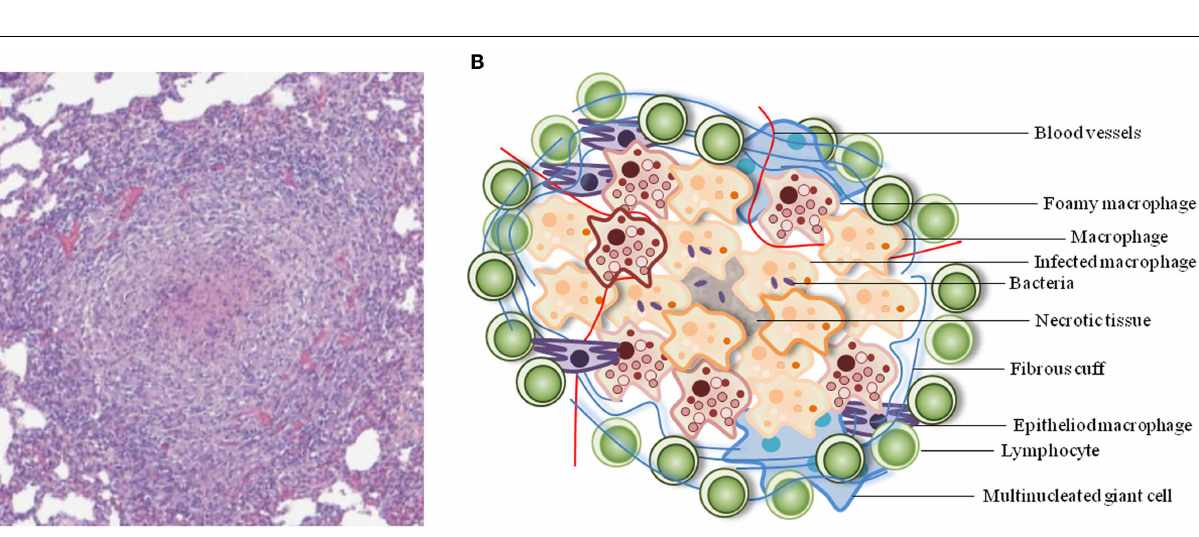
FIGURE 1 |Typical architecture of aTB granuloma. (A) Representative granuloma with central necrosis from minipig lung tissue. Histological samples were formalin-fixed, cut, and stained with hematoxylin-eosin. Adapted from Gil et al. (2010). (B) Schematic of the cellular constituents of aTB